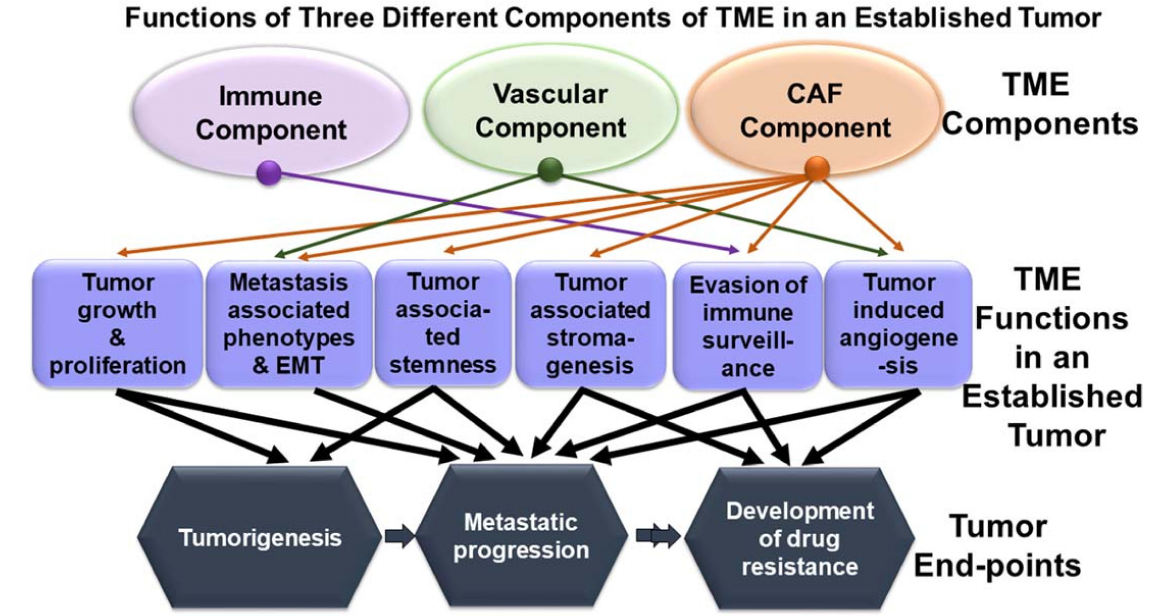
Figure 1. CAF component of TME plays a critical role in promoting tumorigenesis and determines tumor fate in solid tumors. The relationship between TME components (CAF compartment, immune compartment, and vascular